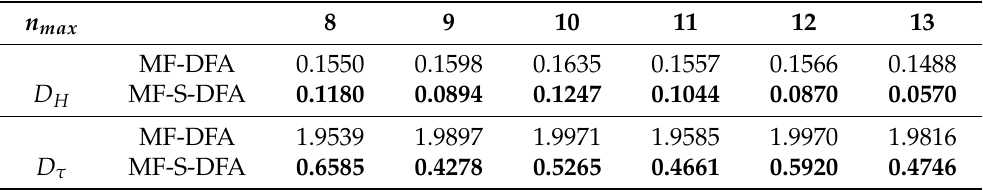
Figure 5. Multifractal analysis of the constructed multiplicative cascade time series: ( a ) relative error H err ( q ) of MF-DFA and MF-S-DFA algorithms, ( b ) relative error τ err ( q ) of MF-DFA and MF-S-DFA algorithms. A color version of the figure is available in the web version of the article. Table 1. D H and D τ for two methods with different lengths of simulation data.